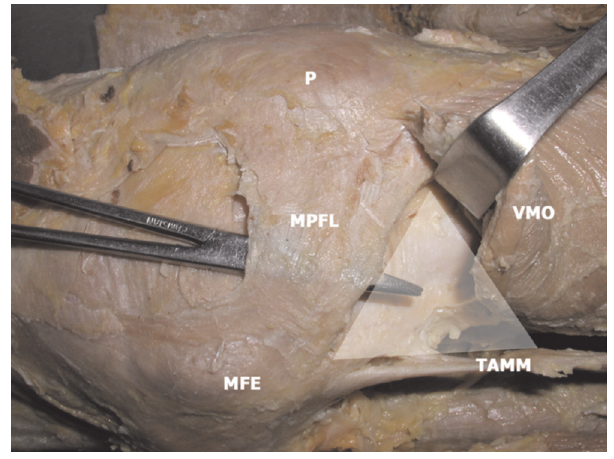
Figure 2 - Triangular area between the MPFL, VMO and TAMM. MPFL - medial patellofemoral ligament; VMO - vastus medialis obliquus; MFE - medial femoral epicondyle; P - patella; TAMM - tendon of the ad- ductor magnus